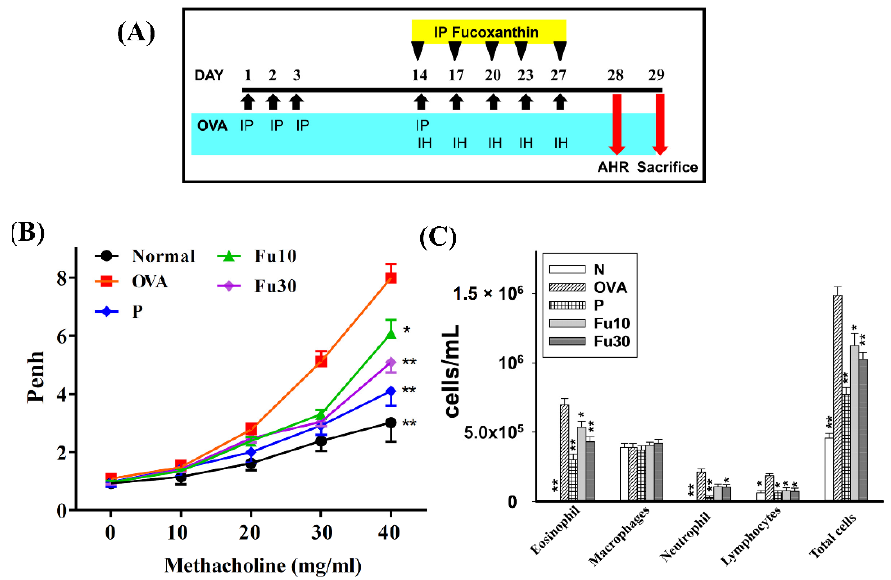
Figure 4. The effect of fucoxanthin (Fu) on AHR and cell counts in the BALF of asthmatic mice. ( A ) On days 1–3 and 14, the mice were sensitized with OVA via intraperitoneal injection (IP) and then challenged with 2% OVA inhalation (IH) on days 14, 17, 20, 23, and 27. One hour before the OVA challenge or methacholine inhalation, the mice were treated with fucoxanthin or DMSO ( n = 10 mice/group) via intraperitoneal injection. ( B ) The mice inhaled increasing doses of methacholine and AHR, assessed as Penh values. ( C ) The inflammatory cells in the BALF were measured. Three independent experiments were analyzed. Data are presented as mean ± SEM. * p < 0.05, ** p < 0.01 compared to the OVA control group. 10 mg/kg and 30 mg/kg fucoxanthin were named as Fu10 and Fu30, respectively. 5 mg/kg prednisolone was named as P.